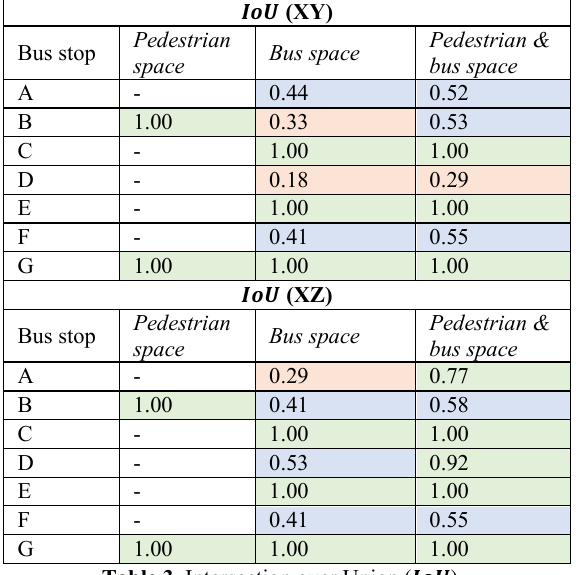
Figure 12. Pedestrian & bus space allocated for bus stop G. The estimated box is coincident with the ground